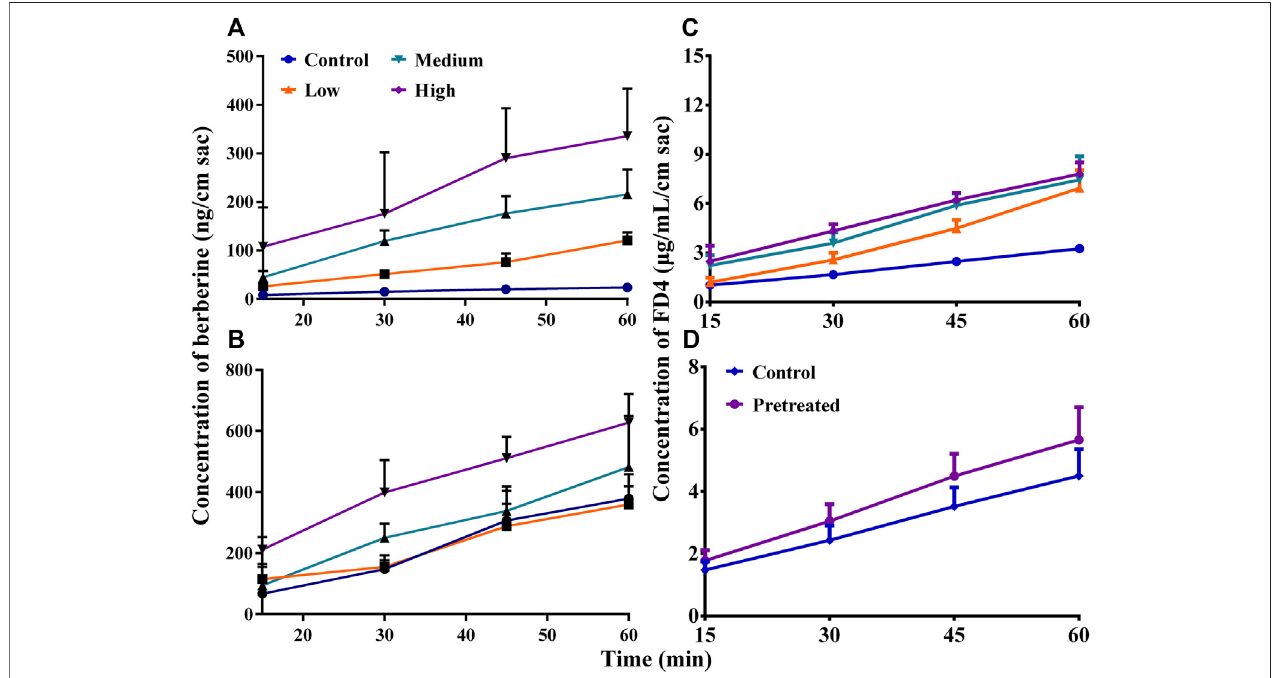
FIGURE 5 | Studies in mouse gut sacs (Mean ± SD, n (cid:2) 3). (A,B) , effects of malic acid on the absorption and ef fl ux of berberine hydrochloride (BBR, 200 μ g/ml) in mousegutsacs,respectively; (C,D) ,effectsofthepresenceandpretreatment(for4 h)ofmalicacidontheabsorptionof fl uoresceinisothiocyanate-labeleddextran(FD4, 3 mg/ml) in mouse gut sacs, respectively. Low, medium, and high: 4.9, 14.7, or 49.0 mg/ml,